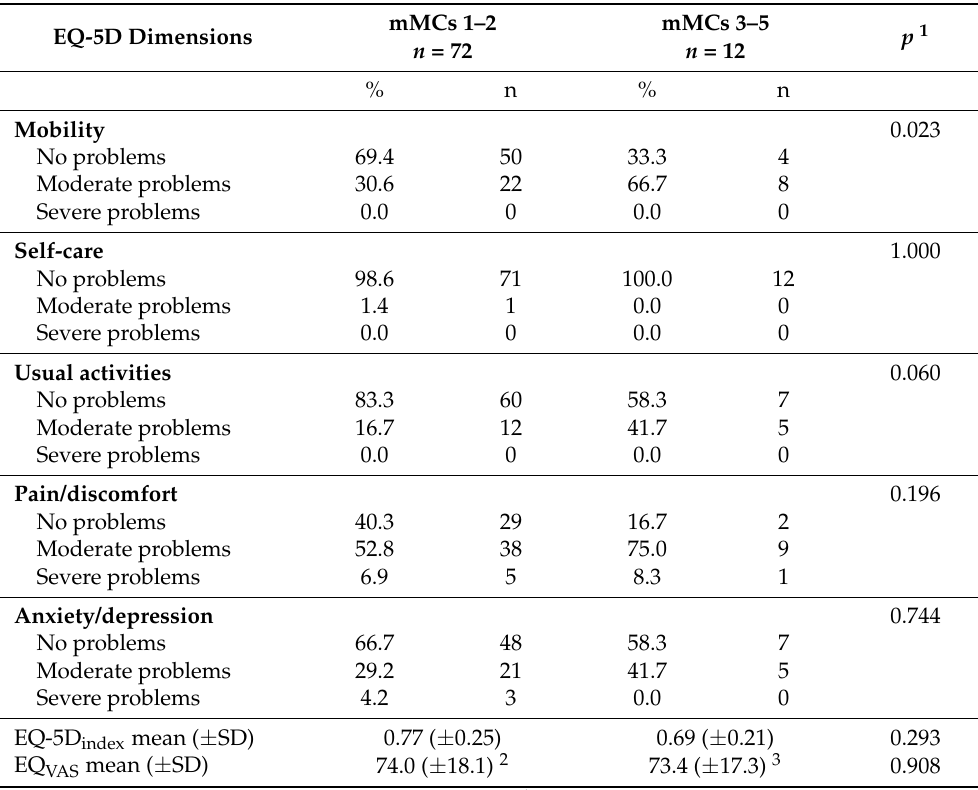
Table 3. Comparison of participants with mMCs grade 1–2 to mMCs 3–5 regarding EQ-5D dimen- sions, EQ-5D index and EQ VAS.